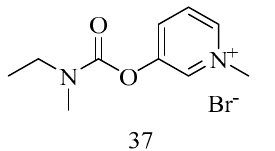
Figure 11. Pyridostigmine bromide.